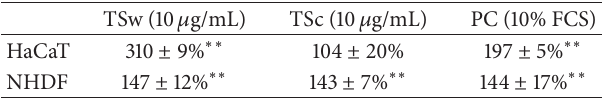
Table 3: Effect of tamarind xyloglucans on migration of HaCaT and NHDF. Migration was investigated by scratch assay for